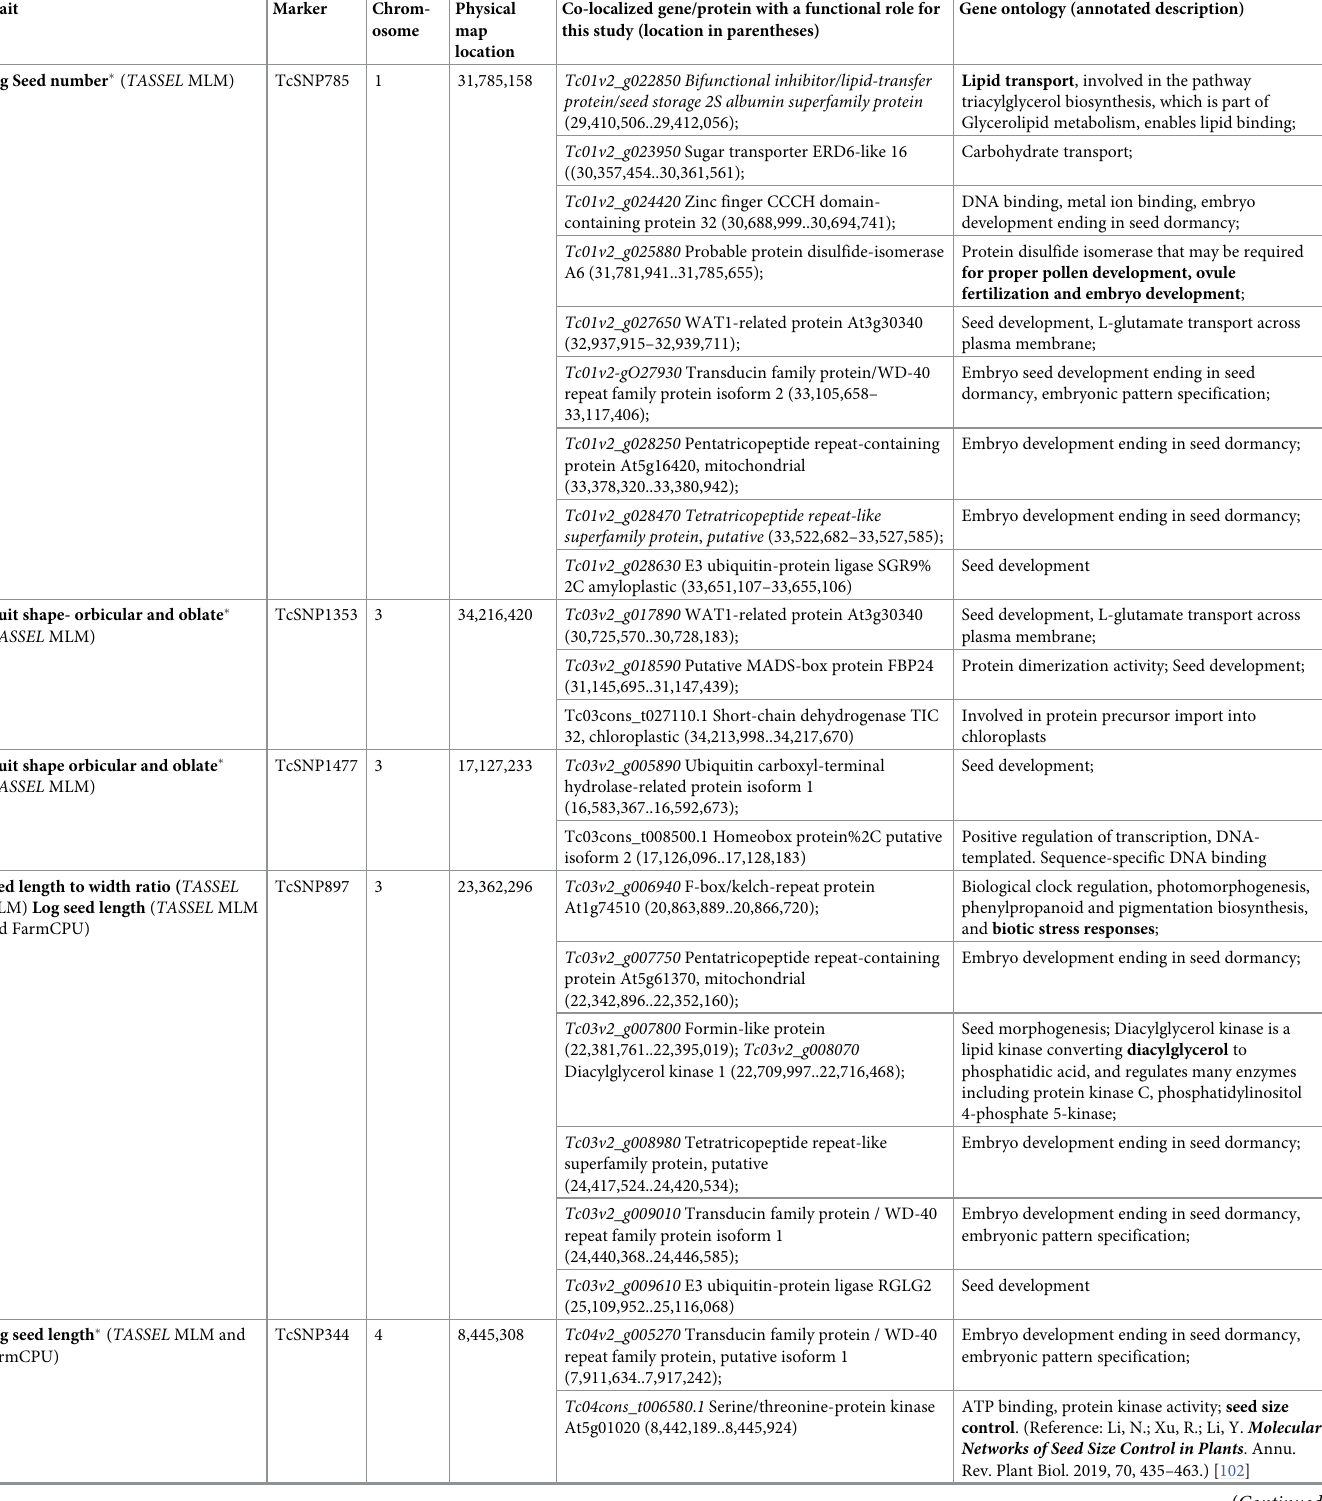
Table 4. Genes co-localized with SNP markers significantly associated with phenotypic traits.